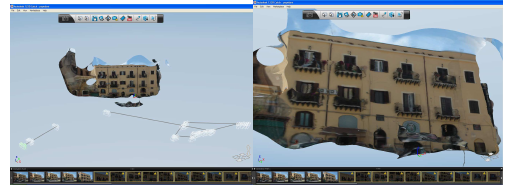
Figure 4: 123D Catch : civil building in